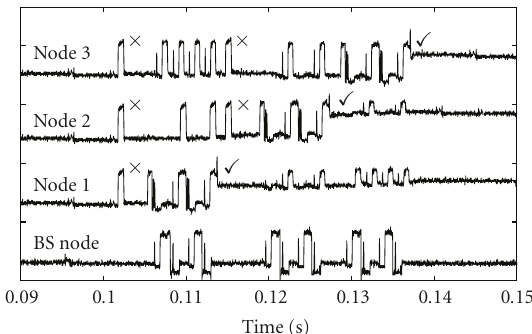
Figure 8: AAO using three nodes and a coordinator over 2C-WSN.